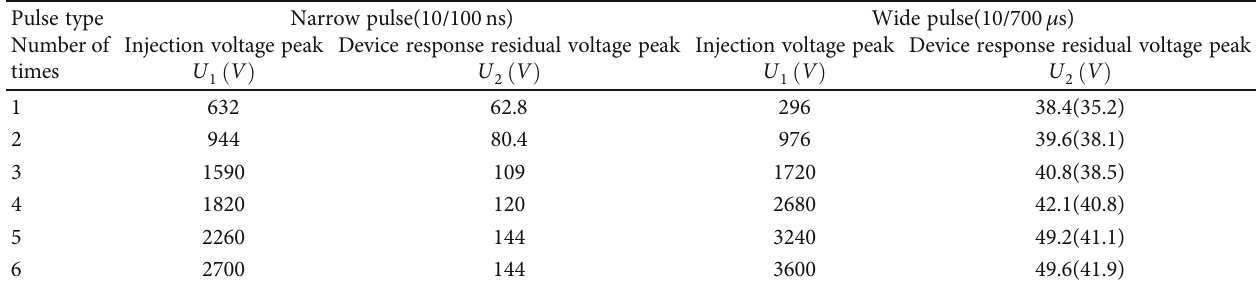
Table 5: Test results of TVS ’ s ability to suppress electromagnetic pulse (TVS type is 1.5KE36CA).